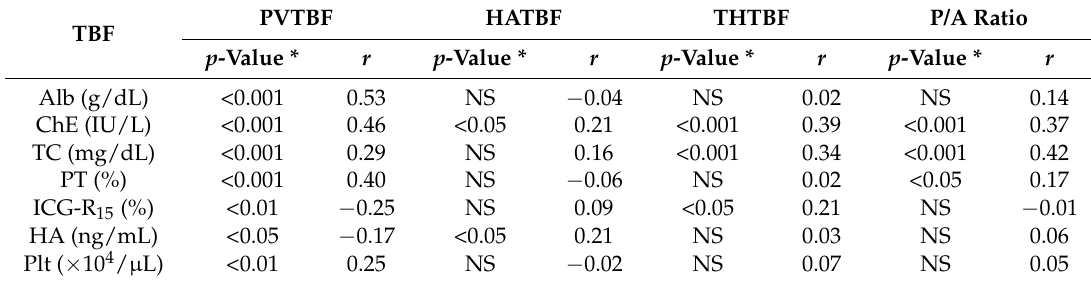
Table 5. Correlations of liver function and hepatic tissue blood flow in